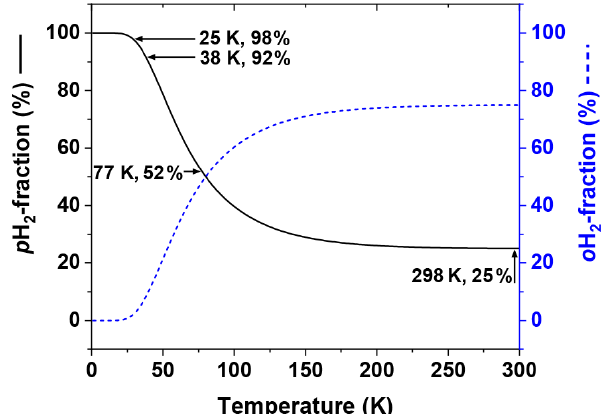
Figure 2. Thermal equilibrium fractions of p H 2 and o H 2 as a func- tion of temperature calculated with Eq. (1) and J = 6. Four temper- ∼= 25%, atures are marked: (1) 298K – “room temperature”, f p H 2 ∼ = 52%, (2) 77K – the boiling temperature of liquid nitrogen, f p H 2 (3) 38K – medium conversion temperature of the Bruker p H 2 gen- ∼= 92%, and (4) 25K – conversion temperature of erator, f p H 2